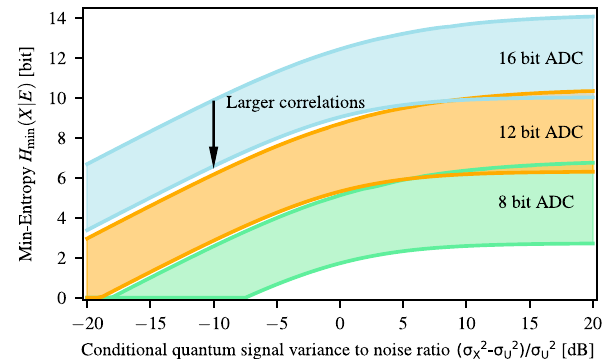
Fig. 2 Min-entropy versus the conditional quantum signal-to-noise ratio. Min-entropy for 8-, 12-, and 16-bit analog-to-digital converter (ADC) resolution versus the ratio of conditional variance of the vacuum fl uctuations and the conditional variance of the excess noise, ð σ 2 Here σ 2 X and σ 2 U are the conditional variance of the measurement outcomes and of the excess noise, respectively. The shaded areas indicate the regions between low correlations ( σ 2 X = σ 2 ¼ 0 : 99), upper trace and high correlations ( σ 2 X = σ 2 ¼ 0 : 1), lower trace. Thereby σ 2 is the variance of the measurement outcomes, which has been optimized to obtain the highest min-entropy. The ADC is assumed to be ideal without digitization